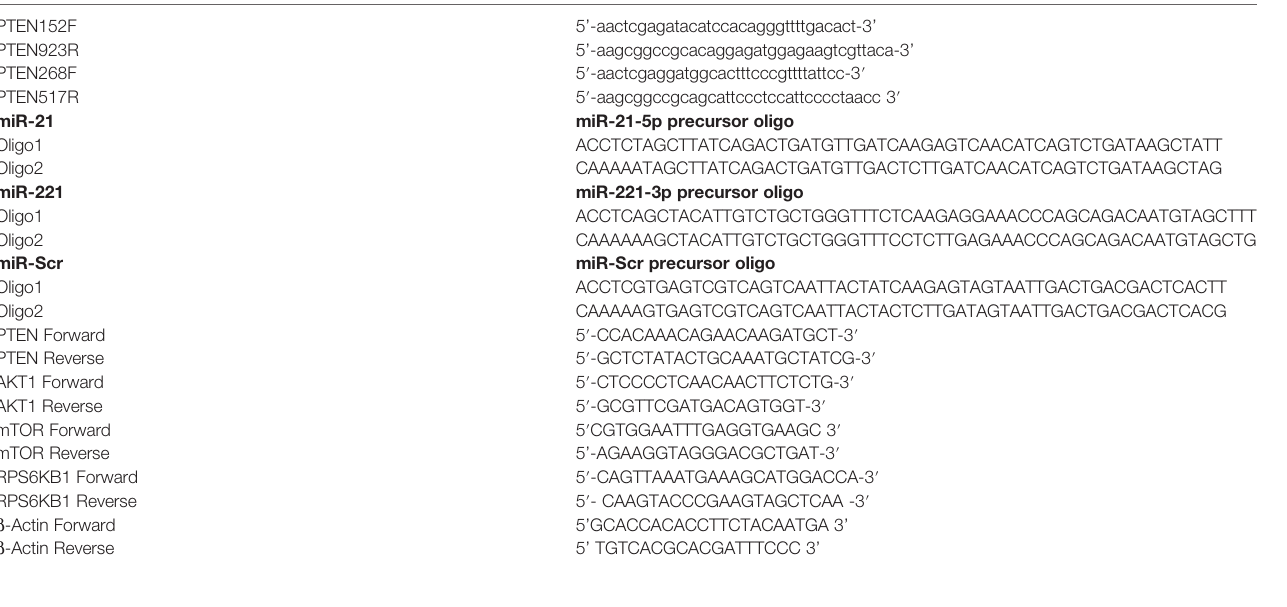
TABLE 1 | Sequence of primers used for PTEN 3 ’ UTR cloning and Sh-miR precursors